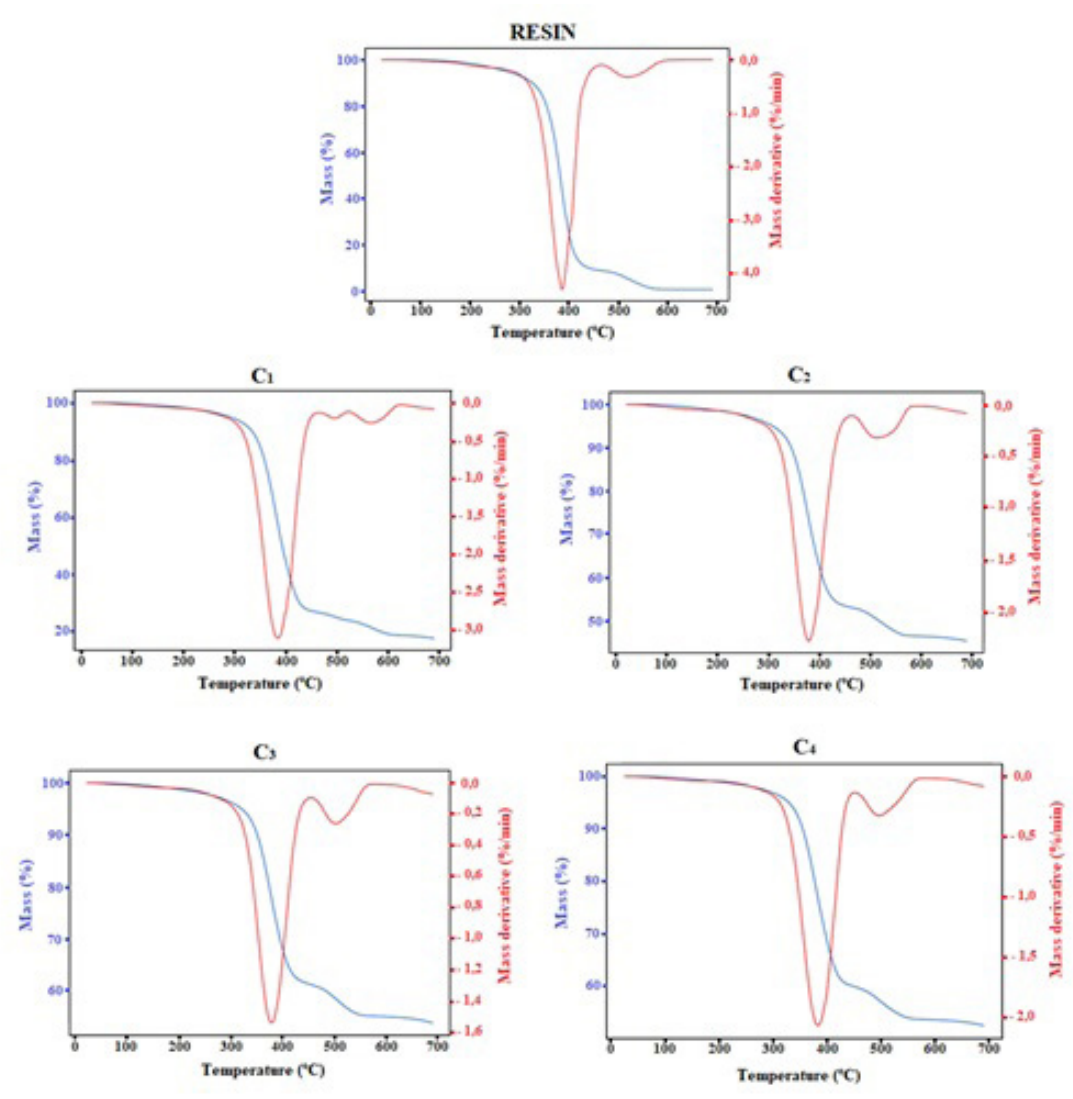
Figure 2. TGA curves for polyester resin